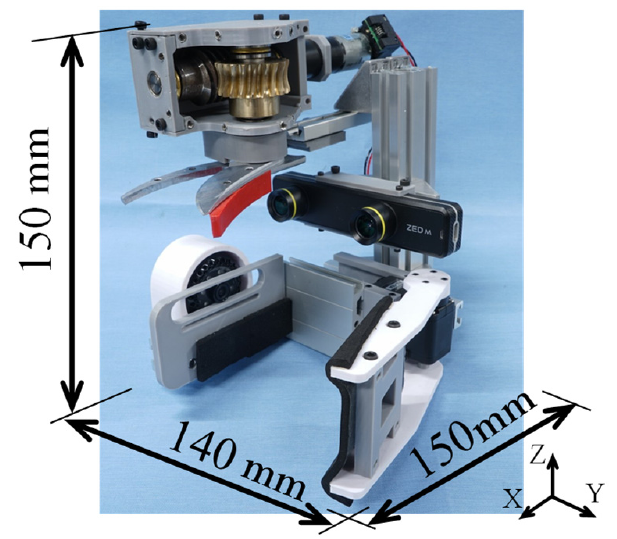
Figure 8. Pruning and harvesting tool.